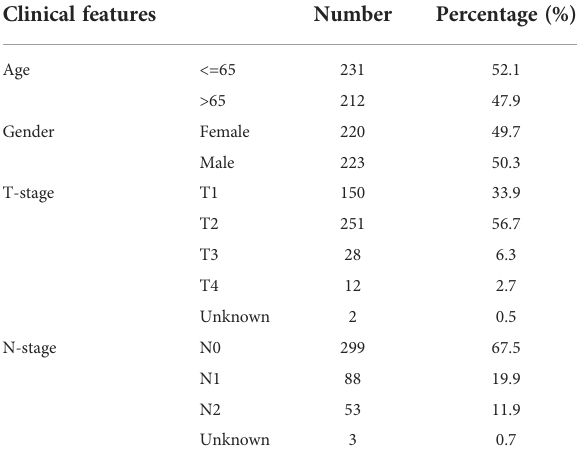
TABLE 2 Baseline information of patients in